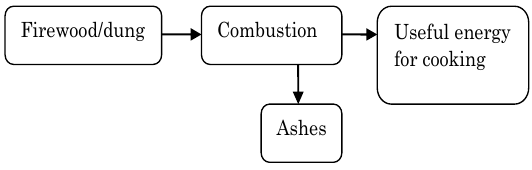
Figure 2. A traditional energy system involving common forest firewood and dry dung.